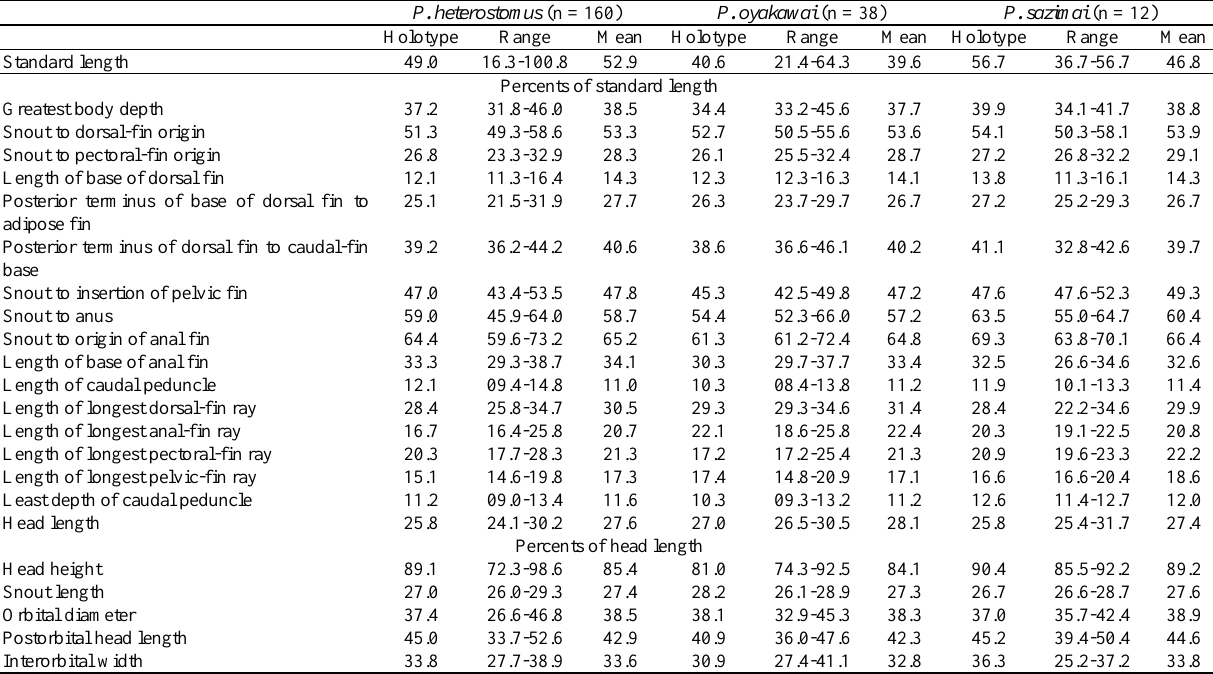
Table 1. Morphometrics of Probolodus heterostomus , P.oyakawai , and P. sazimai . Standard length is expressed in millimeters; measurements 1-16 as percentages of standard length; 17-22 as percentages of head